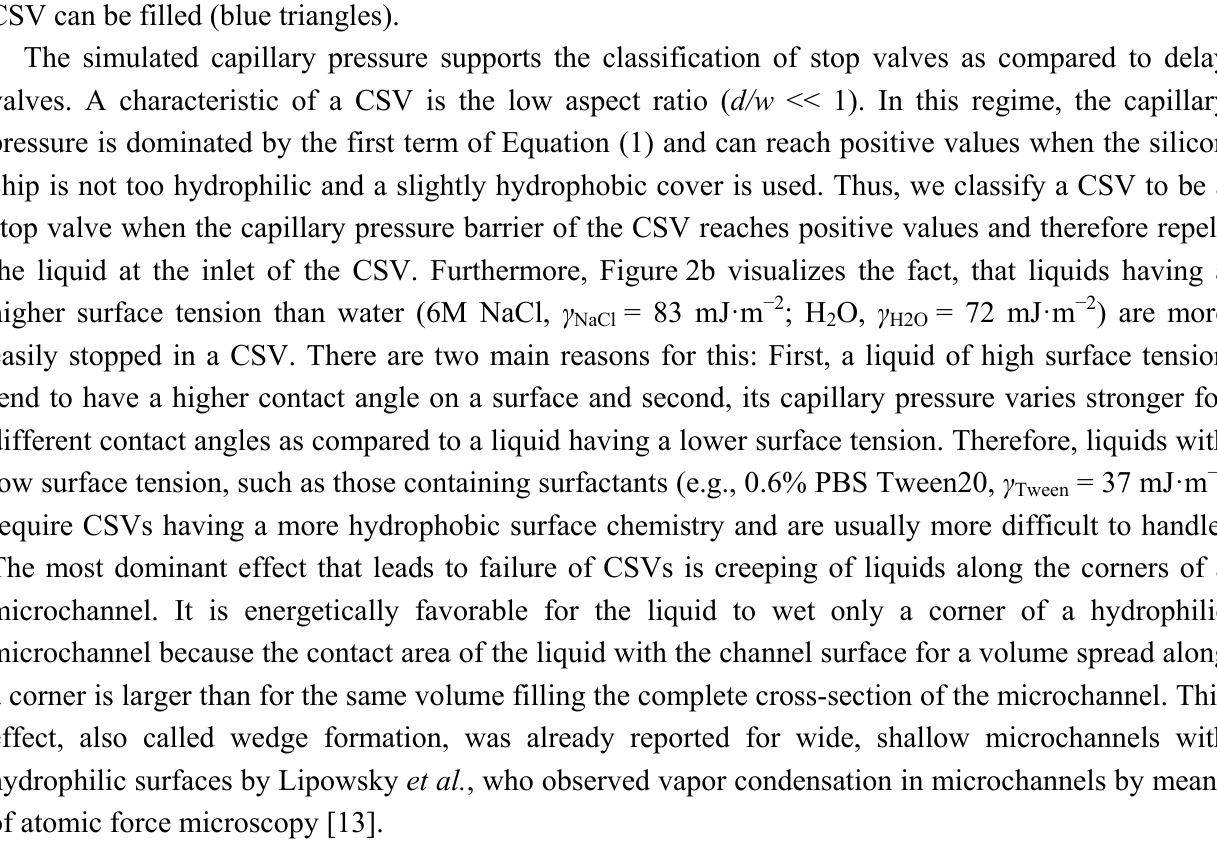
Figure 3. Advanced CSVs having auxiliary structures that help to prevent creeping along corners of microchannels using indentations ( a ), pillars ( b ) or non-continuous channels ( c